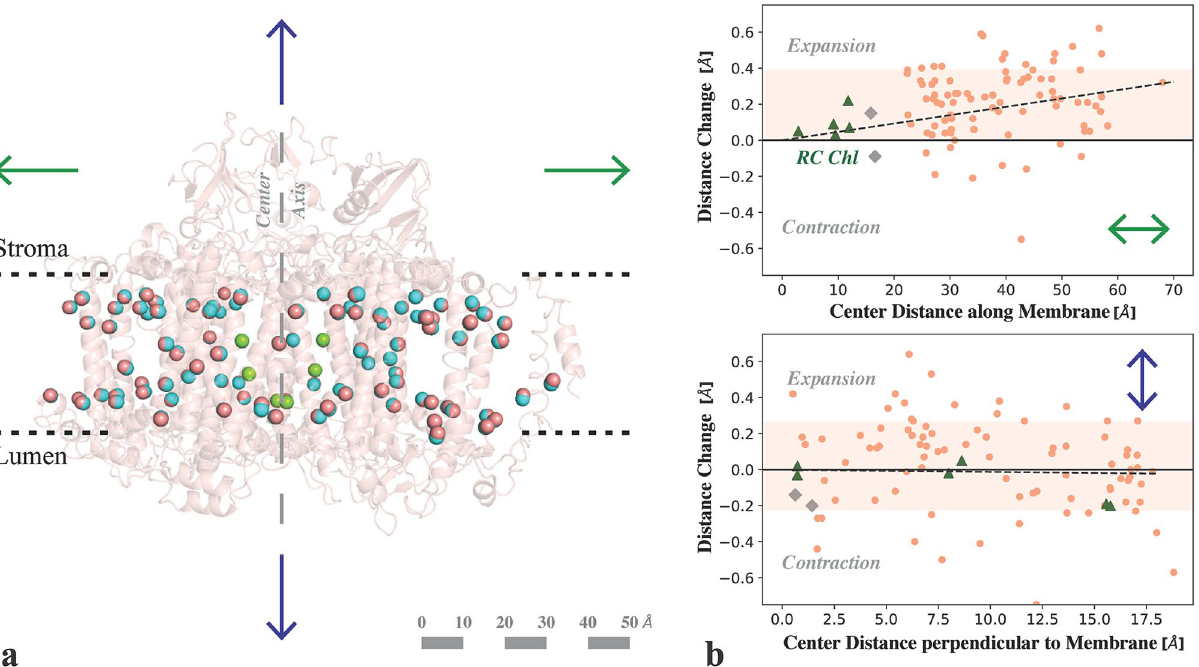
Figure 3. Comparison of Chl positions in PS I between cryogenic and RT structure. ( a ) A representation of the central Mg 2+ (salmon spheres) of all Chls in one monomer of the PS I RT structure (with backbone shown schematically in salmon) overlaid with the Mg 2+ positions from the cryogenic structure (blue). View is along the membrane plane with the stromal side on top and lumenal side on bottom. The center axis, passing through F X and P700 is indicated by a long-dashed line. ( b ) Distance change (RT minus cryo) of the chlorophylls to the center between P700 and F X either along the membrane ( top ) or perpendicular to it ( bottom ). Positive values represent expansion, negative contraction at room temperature. The 1-σ region around the average is highlighted. The Chls involved in charge separation are marked as green triangles, the closest two Chls of the antenna as gray diamonds. The room temperature structure shows an average expansion by about 0.2 Å along the membrane plane. The distance change perpendicular to the membrane is distributed symmetrically around the zero line. Figure generated with Pymol v. 2.4.0a0, https:// pymol. org, Python v. 3.7.6, Matplotlib 3.2.1, https:// matpl otlib.